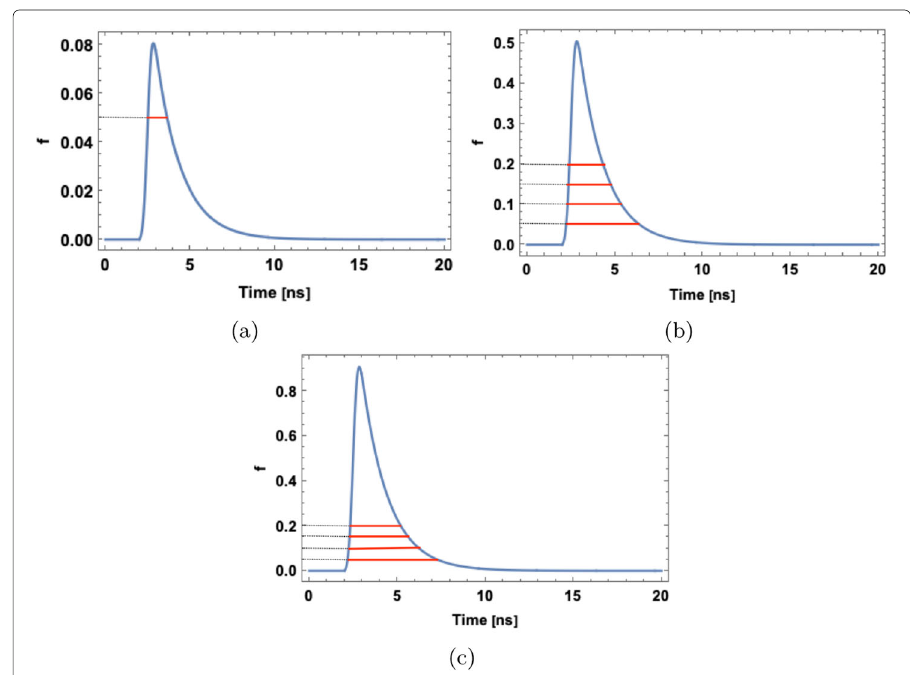
Fig. 10 Time distribution spectra of emitted light is calculated by using Eq. 3 for three cases representing signals corresponding to the energy deposition of 80 keV ( a ), 500 keV ( b ), and 900 keV ( c